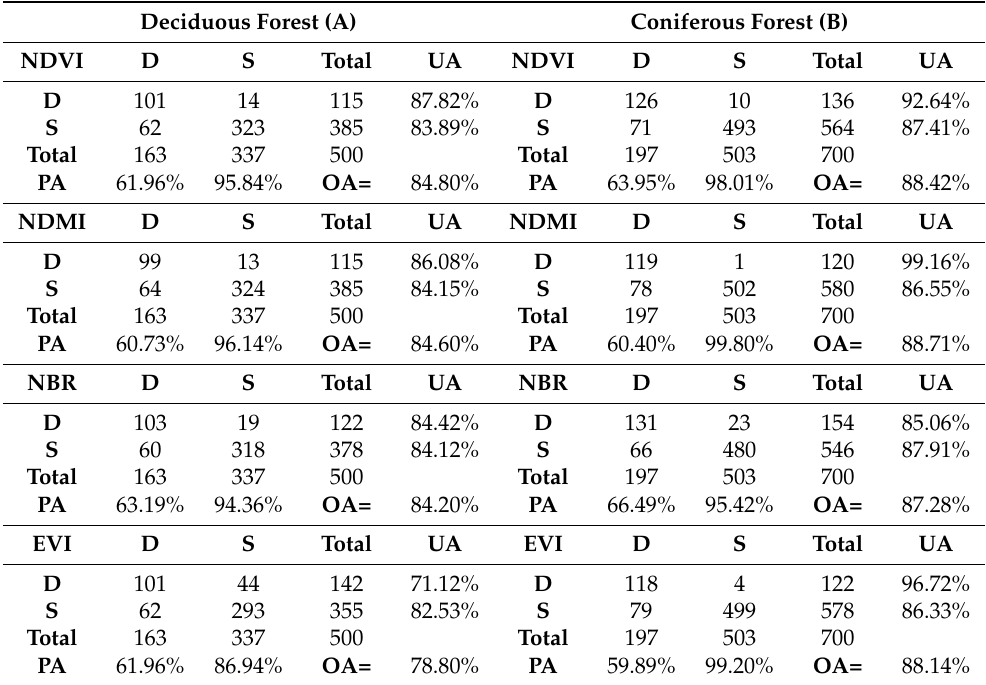
Table 4. Confusion matrix for accuracy assessment. This matrix shows Vis’ accuracy for detecting deforestation by implementing the BFASTMonitor algorithm over deciduous and coniferous forests. Deciduous Forest (A)